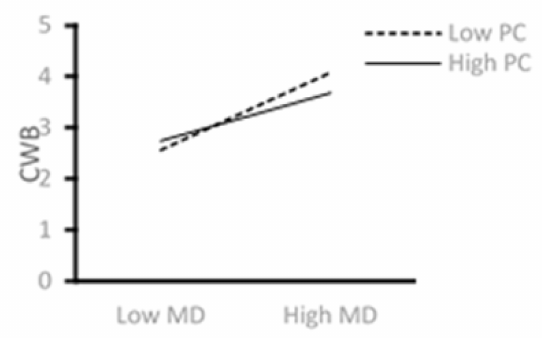
Figure 3. The moderating role of PC.